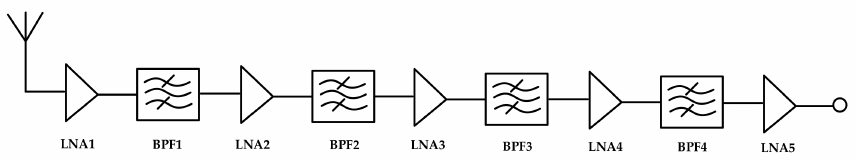
Figure 9. Block diagram of radio frequency (RF) front end of microwave radiometer (including 5-stage low noise amplifier and 4-stage bandpass filter).